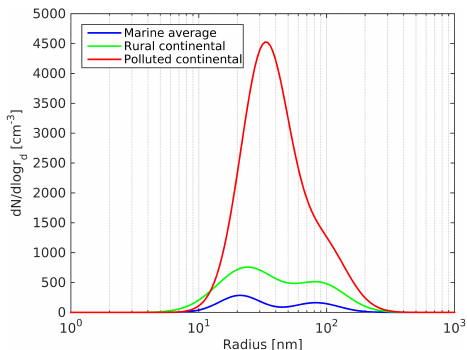
Figure 2. Marine average, rural continental, and polluted continen- tal log-normal aerosol size distributions used to generate calibration data. The distributions are calculated using the true log-normal pa- rameters given in Table